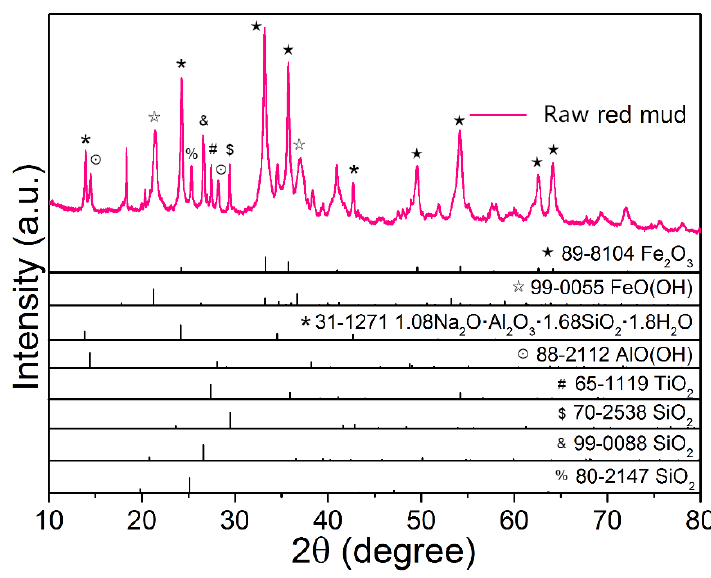
Table 1. The chemical composition of raw red mud (wt.%).